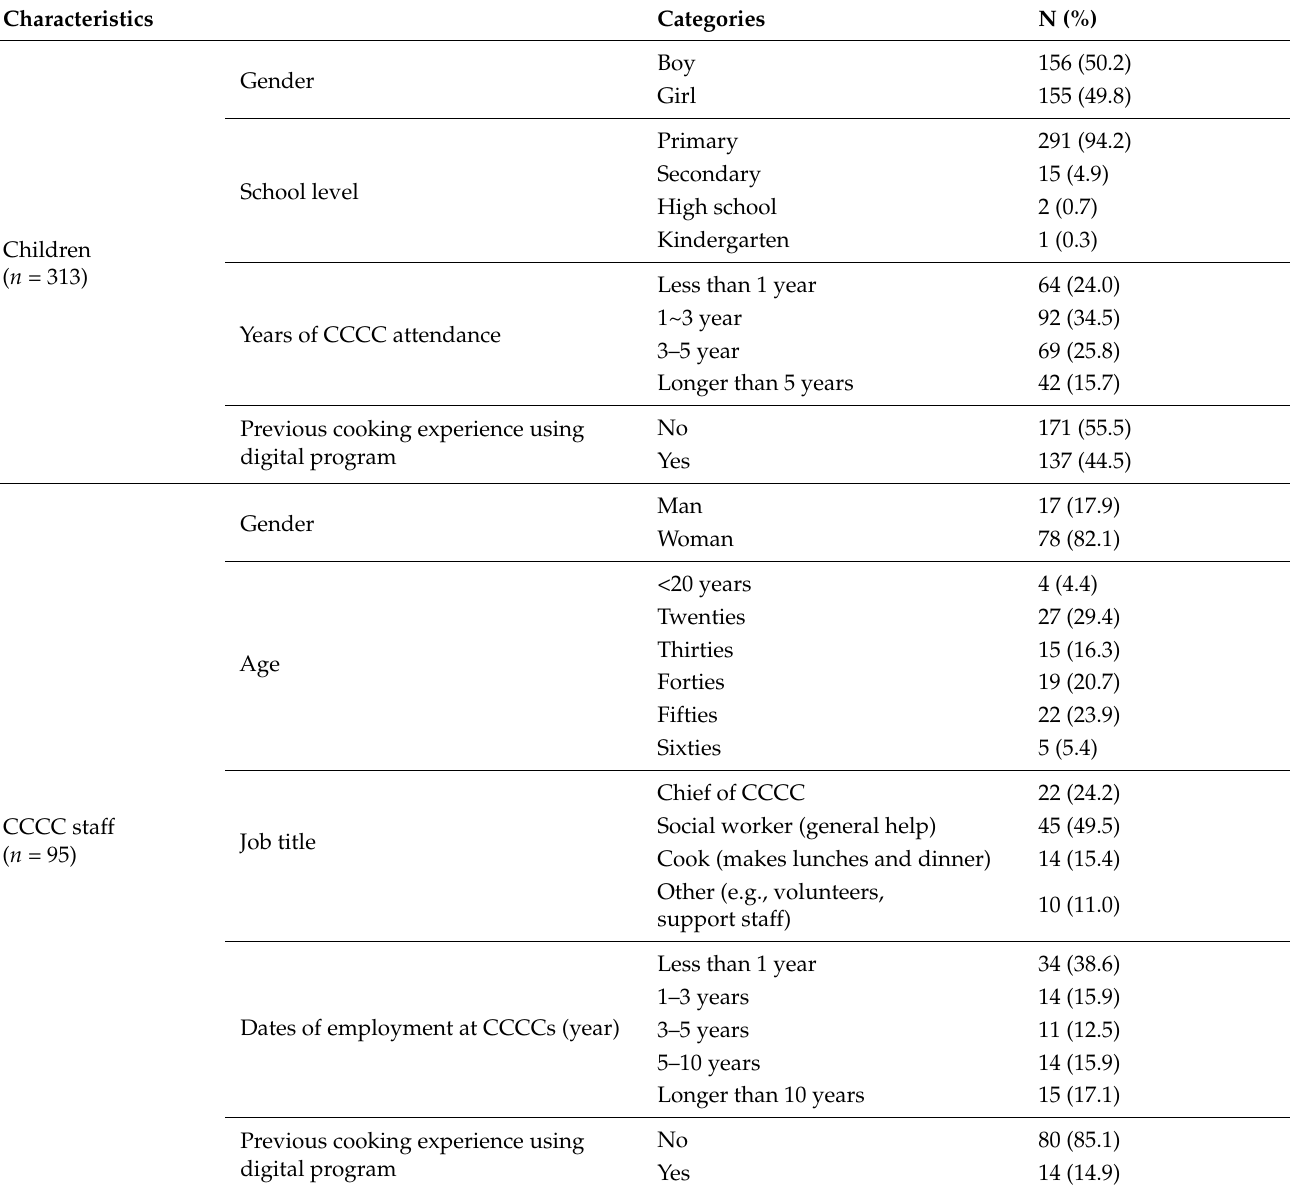
Table 1. Demographic profile of the